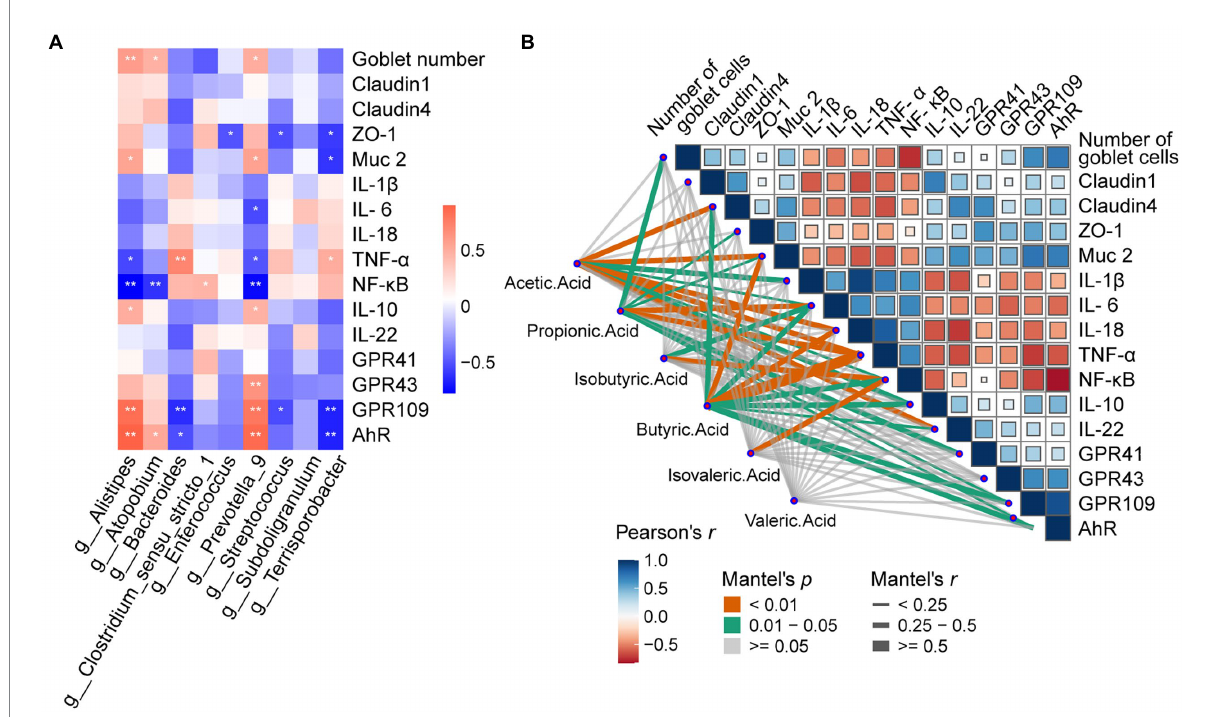
FIGURE 8 Effects of dietary Pectin supplementation on Microbiota-Metabolites Correlation. (A) Spearman’s correlation matrix of Short-chain fatty acids (SCFA), and relative microorganisms in piglets. The direction of ellipses represents positive or negative correlations, and the width of ellipses represents the strength of correlation (narrow ellipse = stronger correlation). Signification is presented as * p < 0.05, ** p < 0.01, data are presented as the mean ± SE (B) Pairwise comparisons of cecal genera are shown with a color gradient denoting Spearman’s correlation coefficient. Short-Chain Fatty acids were related to other relevant indicators by partial Spearman tests. Edge width corresponds to the Partial Spearman’s r statistic for the corresponding distance correlations and edge color denotes the statistical